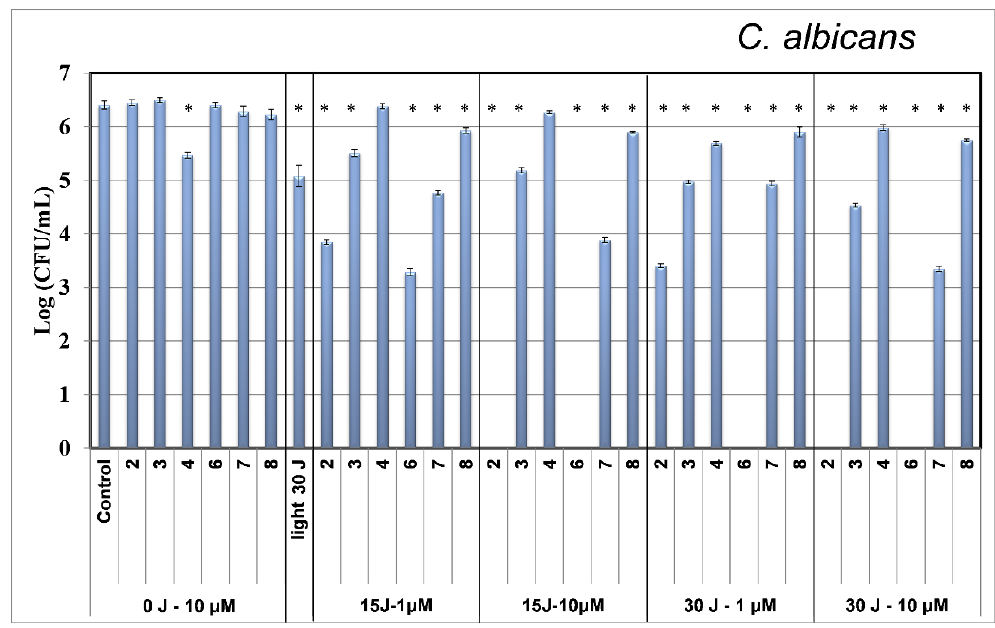
Figure 4. Candida albicans counts (log CFU/mL) for 1 µM and 10 µM of photosensitizers 2 – 4 and 6 – 8 with the light doses of 0 Jcm − 2 (control), 15 Jcm − 2 and 30 Jcm − 2 . Results are presented as mean ± SE. All the experiments were statistically evaluated (Tukey’s test) and are in agreement with significance level of at least p < 0.05. Experiments pointed out with (*) represent p < 0.05 when compared to the control.